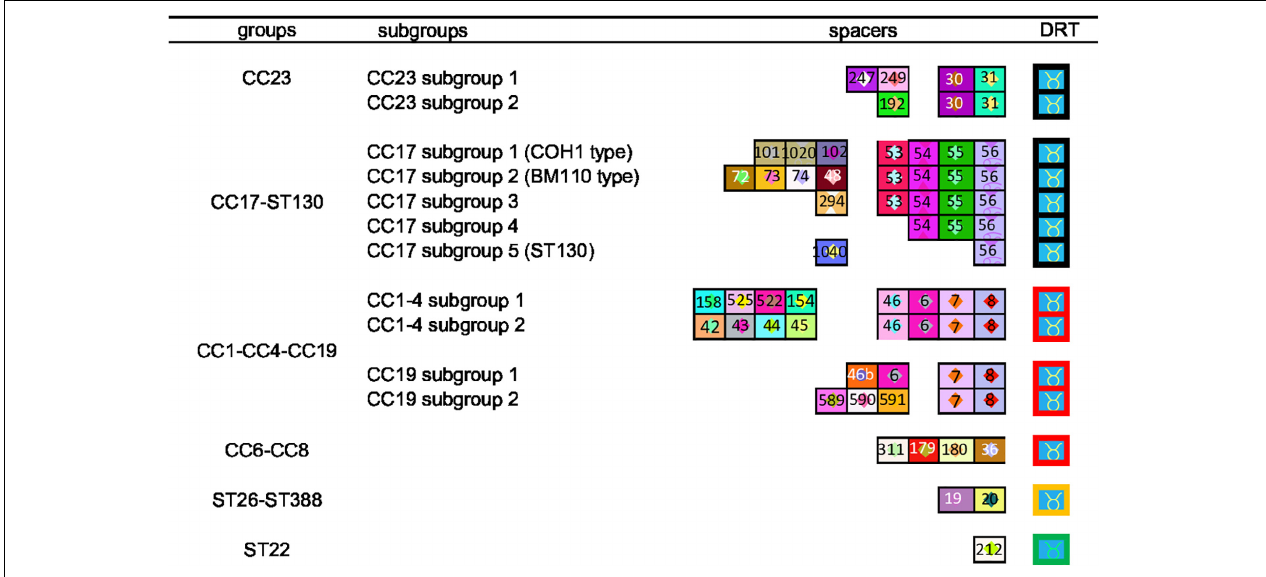
FIGURE 1 | CRISPR clustering according to TDR and ancestral spacers. The CRISPR1 arrays are represented using a macro-enabled Excel tool, whereby spacers are converted into two-color symbols based on spacer sequence. Repeats are not shown except terminal direct repeats (TDRs), which are represented by different colored borders according to their sequence. Spacers were identified by a number attributed following the spacer dictionary (http://crispr.i2bc.paris-saclay.fr/CRISPR compar/Dict/Dict.php). Arrays are oriented with respect to the leader sequence located on the left. A total of 14 clusters were obtained. The six groups were defined by TDR and ancestral spacers. These groups were then divided into subgroups, based on more recent spacers.